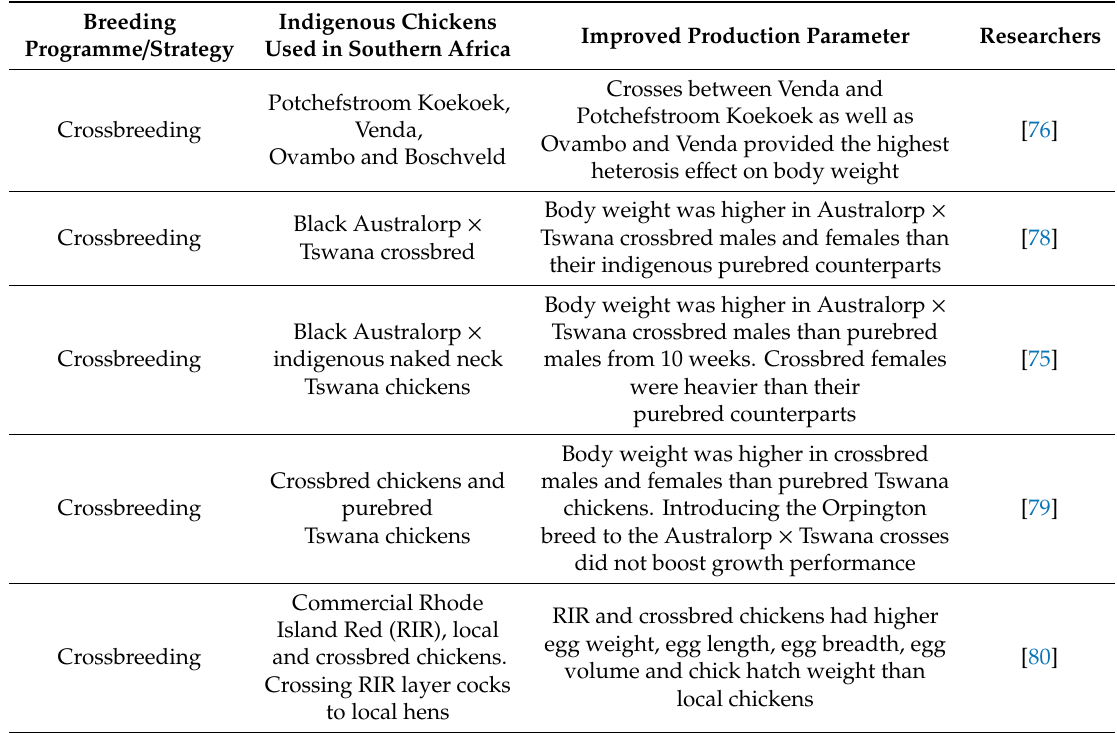
Table 2. Improvement of performance or production of local chickens at a genetic